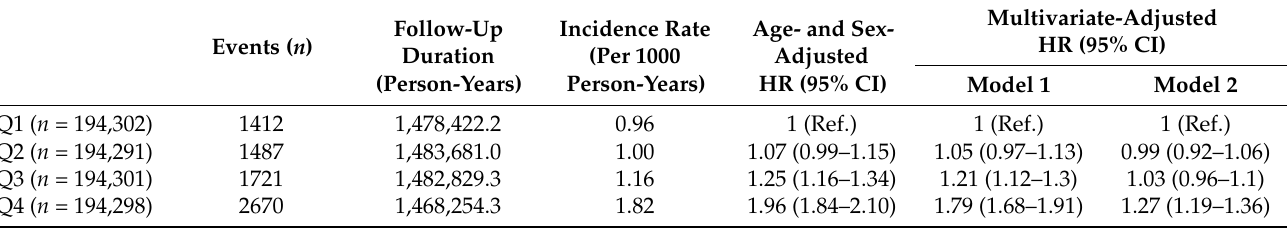
Table 2. Hazard ratios and 95% confidence intervals for the incidence of end-stage of kidney disease by quartiles of fasting glucose variability a .